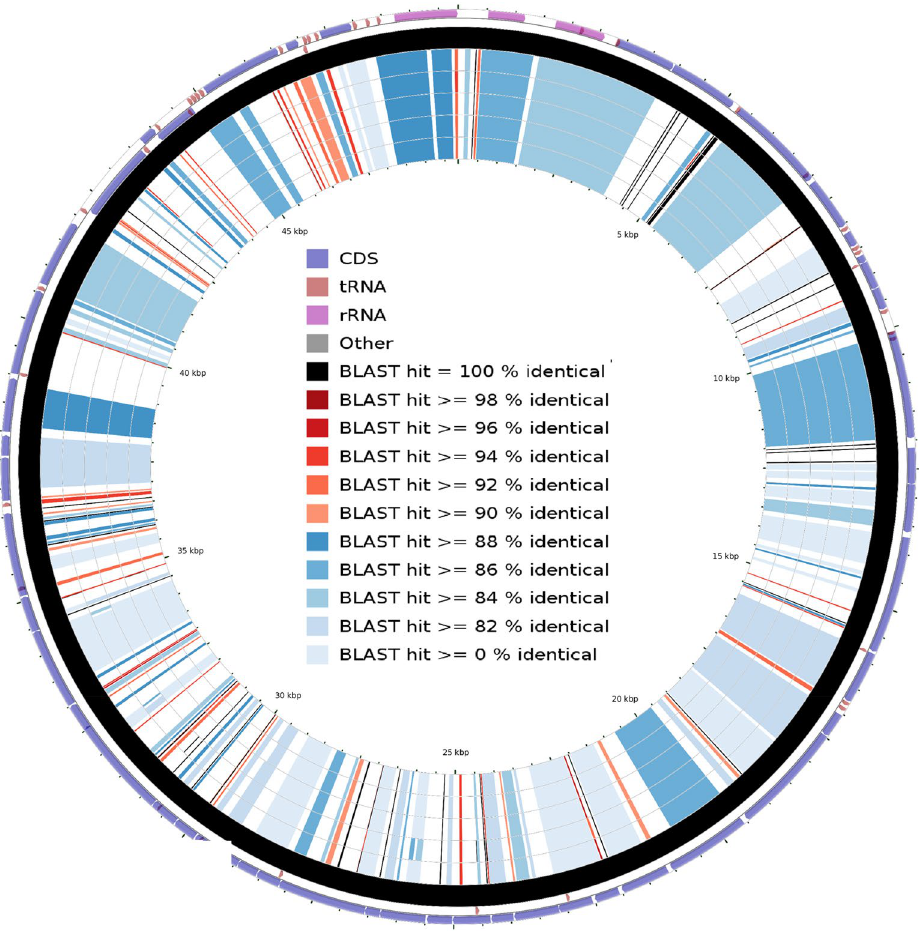
Figure 8. Graphical representation of BLAST results using N. gruberi species (AF288092.1) mitochondrial DNA as a reference and other Naegleria species mitochondrial DNA as a query. From the circle inward: the first and second rings consisting of CDS, tRNA, rRNA and other genes, third ring in black color represent the reference and six to eight rings are representing five N. fowleri